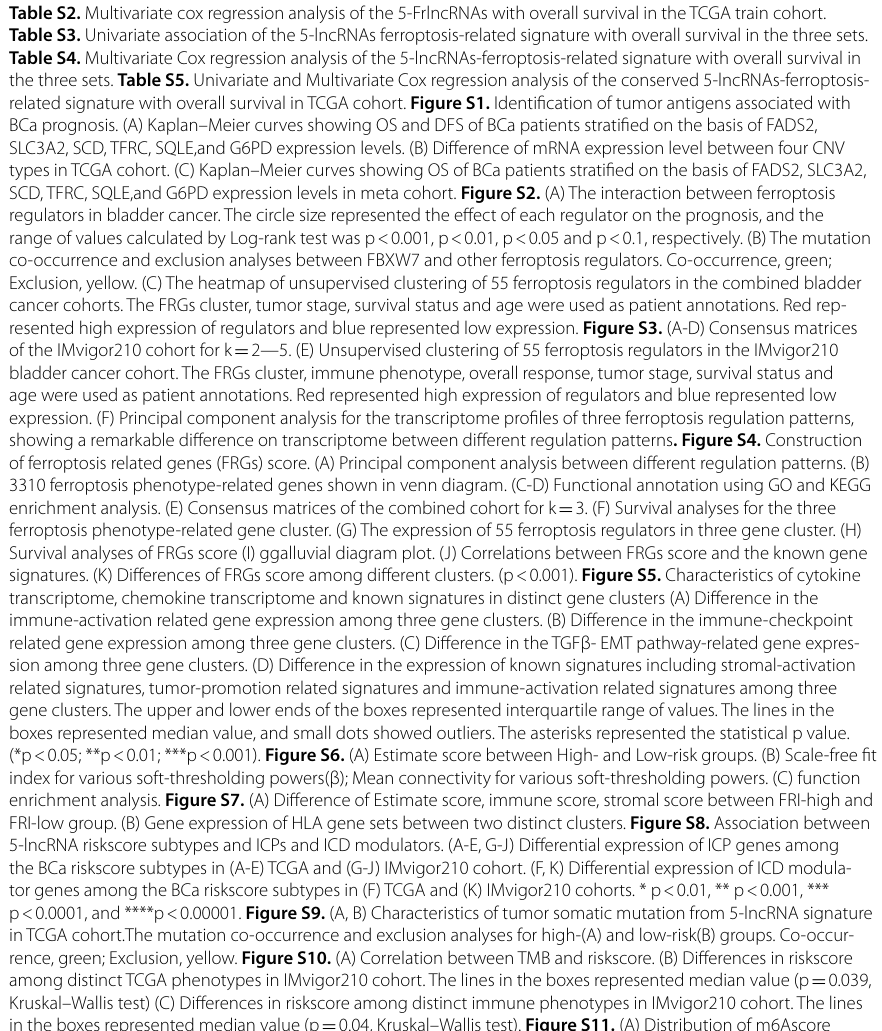
Table S3. Univariate association of the 5‑lncRNAs ferroptosis‑related signature with overall survival in the three sets. Table S4. Multivariate Cox regression analysis of the 5‑lncRNAs‑ferroptosis‑related signature with overall survival in the three sets. Table S5. Univariate and Multivariate Cox regression analysis of the conserved 5‑lncRNAs‑ferroptosis‑ related signature with overall survival in TCGA cohort. Figure S1. Identification of tumor antigens associated with BCa prognosis. (A) Kaplan–Meier curves showing OS and DFS of BCa patients stratified on the basis of FADS2, SLC3A2, SCD, TFRC, SQLE,and G6PD expression levels. (B) Difference of mRNA expression level between four